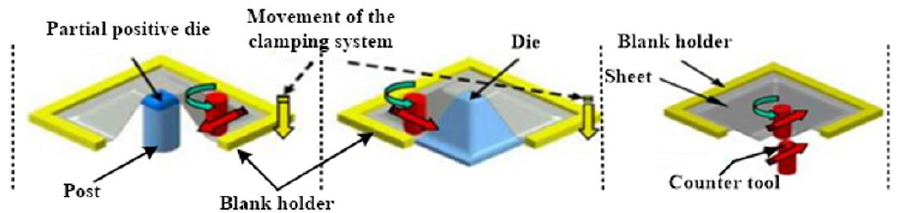
Figure 4. Two-point incremental forming (adapted with permission from Ref. [51], 2005, copyright CIRP). Figure 5. Single-point incremental forming (adapted with permission from Ref. [48], 2004, copyright CIRP).